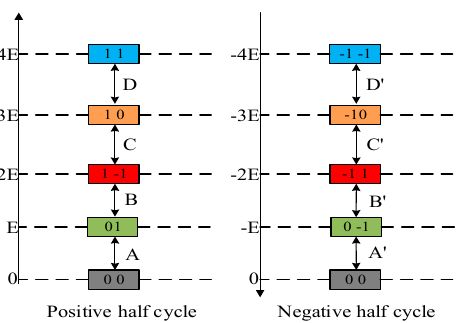
Figure 2. Synthesis of pulse width modulation (PWM) level in different intervals.